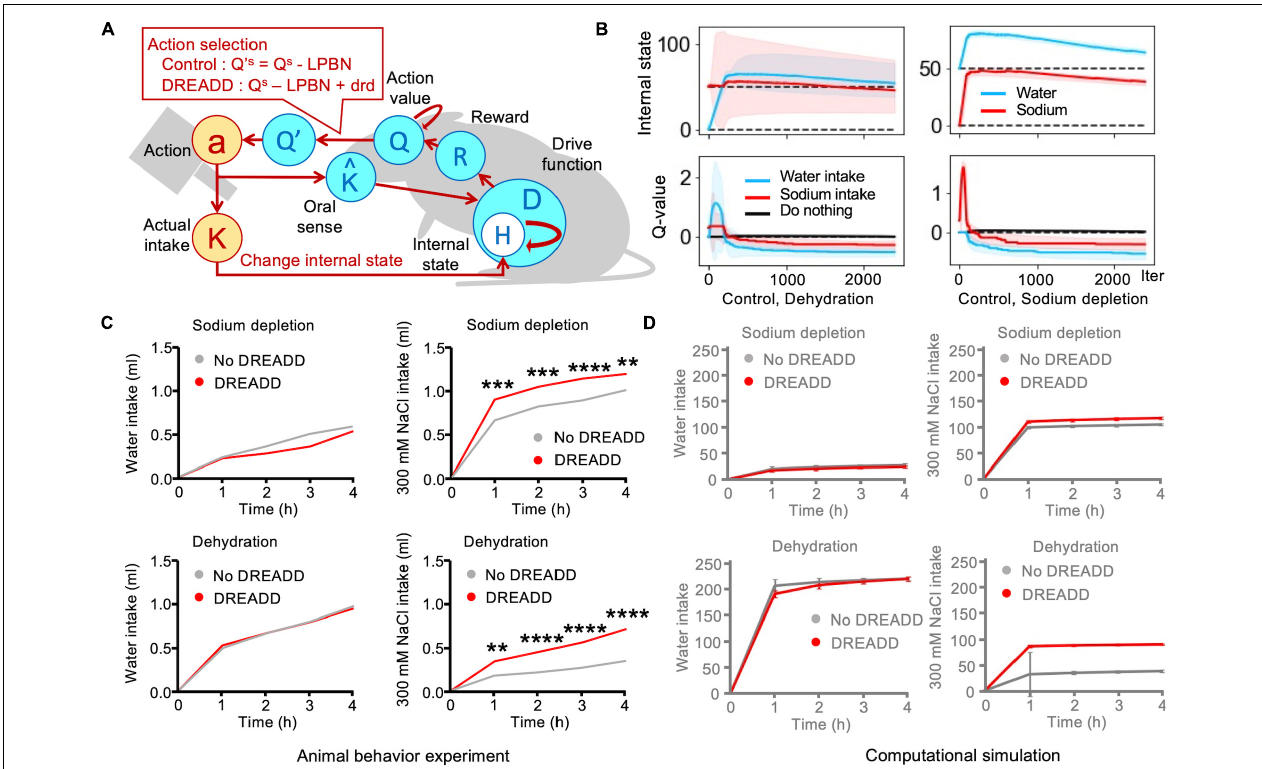
FIGURE 4 | Simulation of designer receptors exclusively activated by designer drugs (DREADD), which involved tonic neuronal suppression of sodium appetite. (A) Schematic illustration of Simulation 4: DREADD. (B) Transitions in the control (no-DREADD) models. Sodium intake values were subtracted from these plots by a negative bias toward sodium appetite. The solid lines represent the results of a trial, and the light-colored error ranges represent the mean ± 2 SD of 100 simulated agents. (C) DREADD experiments increased sodium intake (Park et al., 2020). ** P < 0.01, *** P < 0.001, and **** P < 0.0001. (D) Homeostatic reinforcement models demonstrated equivalent behaviors. The data are averaged over 100 simulated